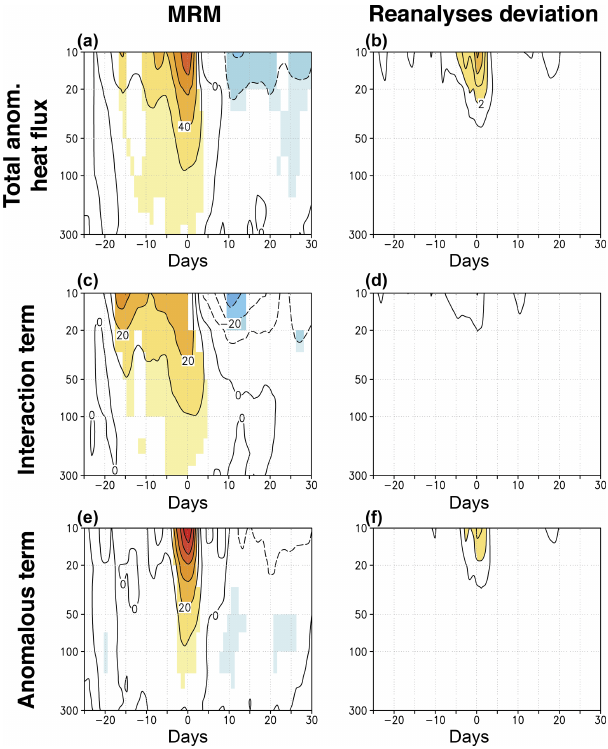
Figure 5. Same as Fig. 4 but for the comparison period (1979–